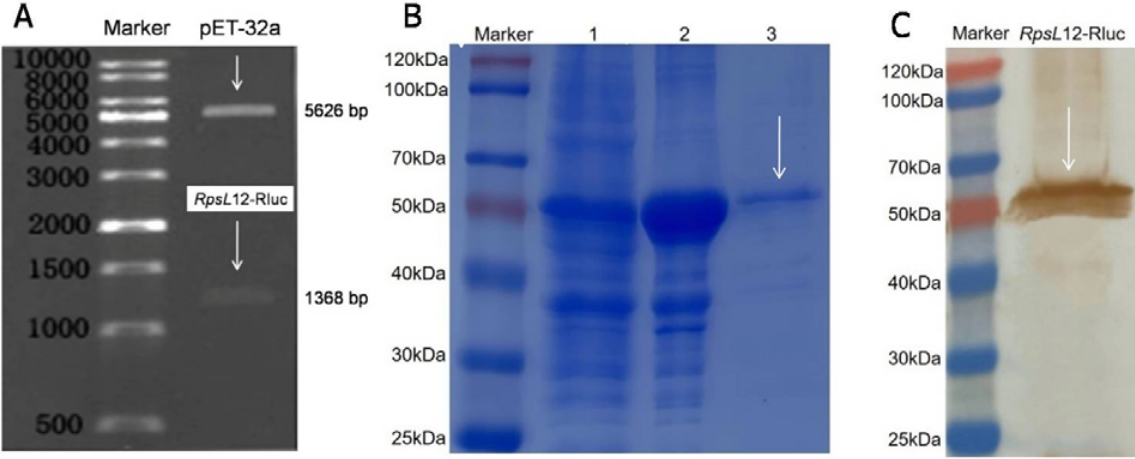
Figure 3. Results of ( A ) agarose gel electrophoresis, ( B ) SDS ‐ PAGE (lane 1, supernatant; lane 2, inclusion body; lane 3, purified fusion protein), and ( C ) Western blotting for characterization of RpsL12–Rluc fusion.